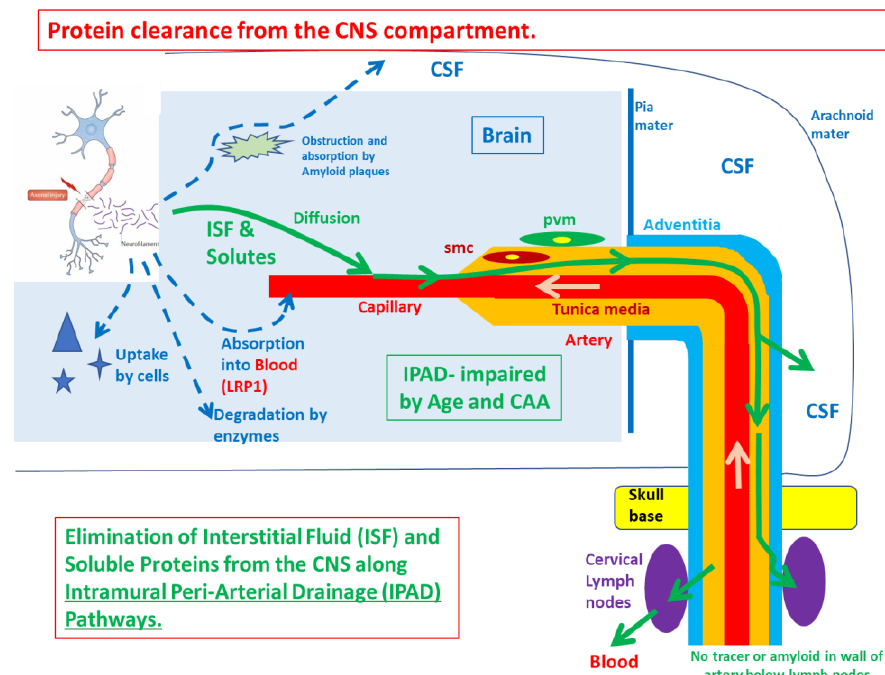
Figure 2. Mechanisms of protein clearance from the CNS compartment. Abbreviations: CAA: cerebral amyloid angiopathy, CSF: cerebrospinal fluid, ISF: interstitial fluid, LRP: Low density lipoprotein receptor-related protein, IPAD: intramural periarterial drainage.